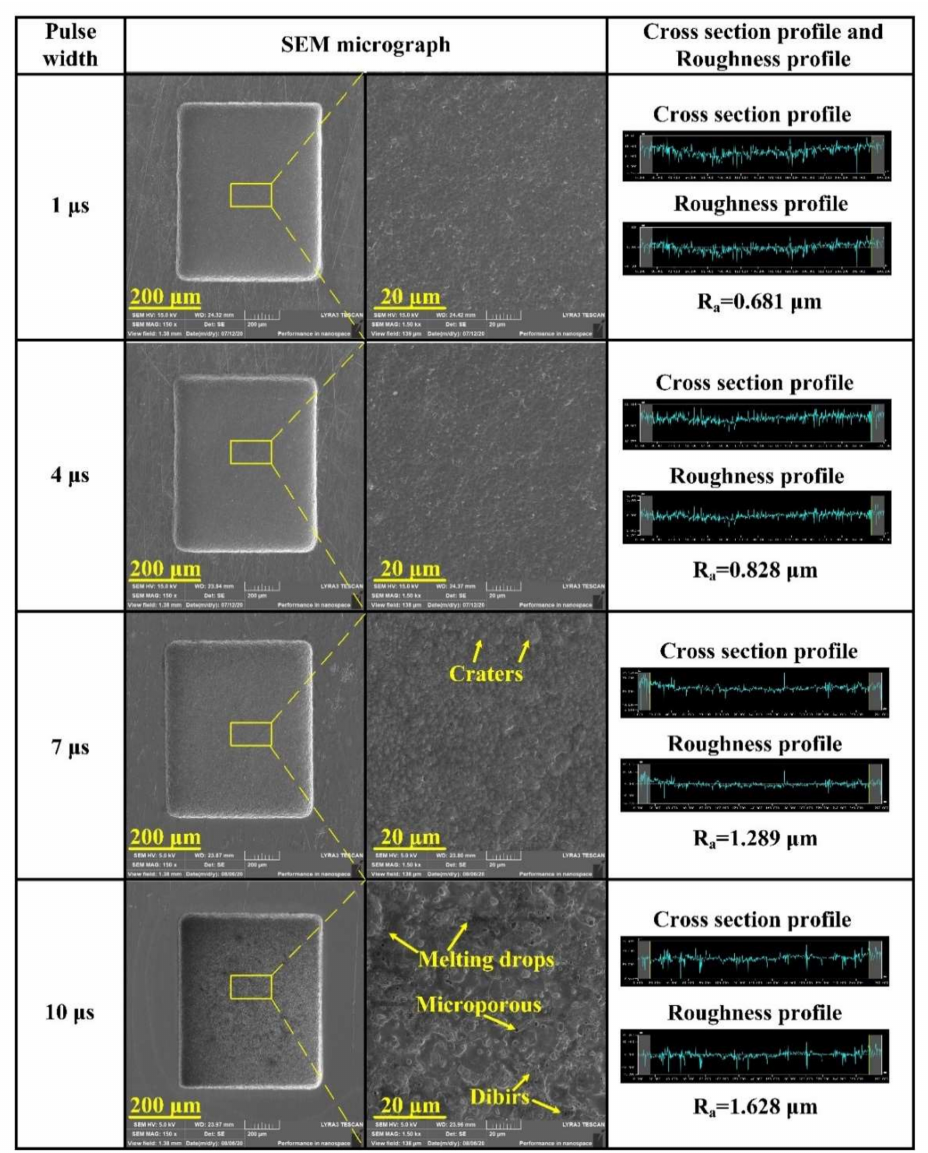
Figure 9. E ff ect of di ff erent pulse widths on surface roughness and SEM micrographs of the microcavities